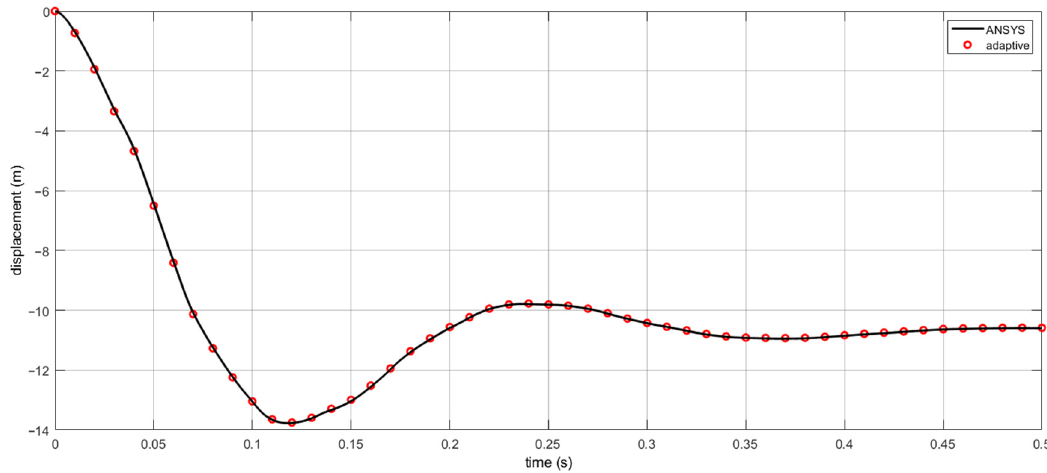
Figure 16. The transient vertical displacement at point A with damping ( 𝑐 = 20 Ns/m ), Δ𝑡 = 0.005 s , under Heaviside step loading with an infinite duration.